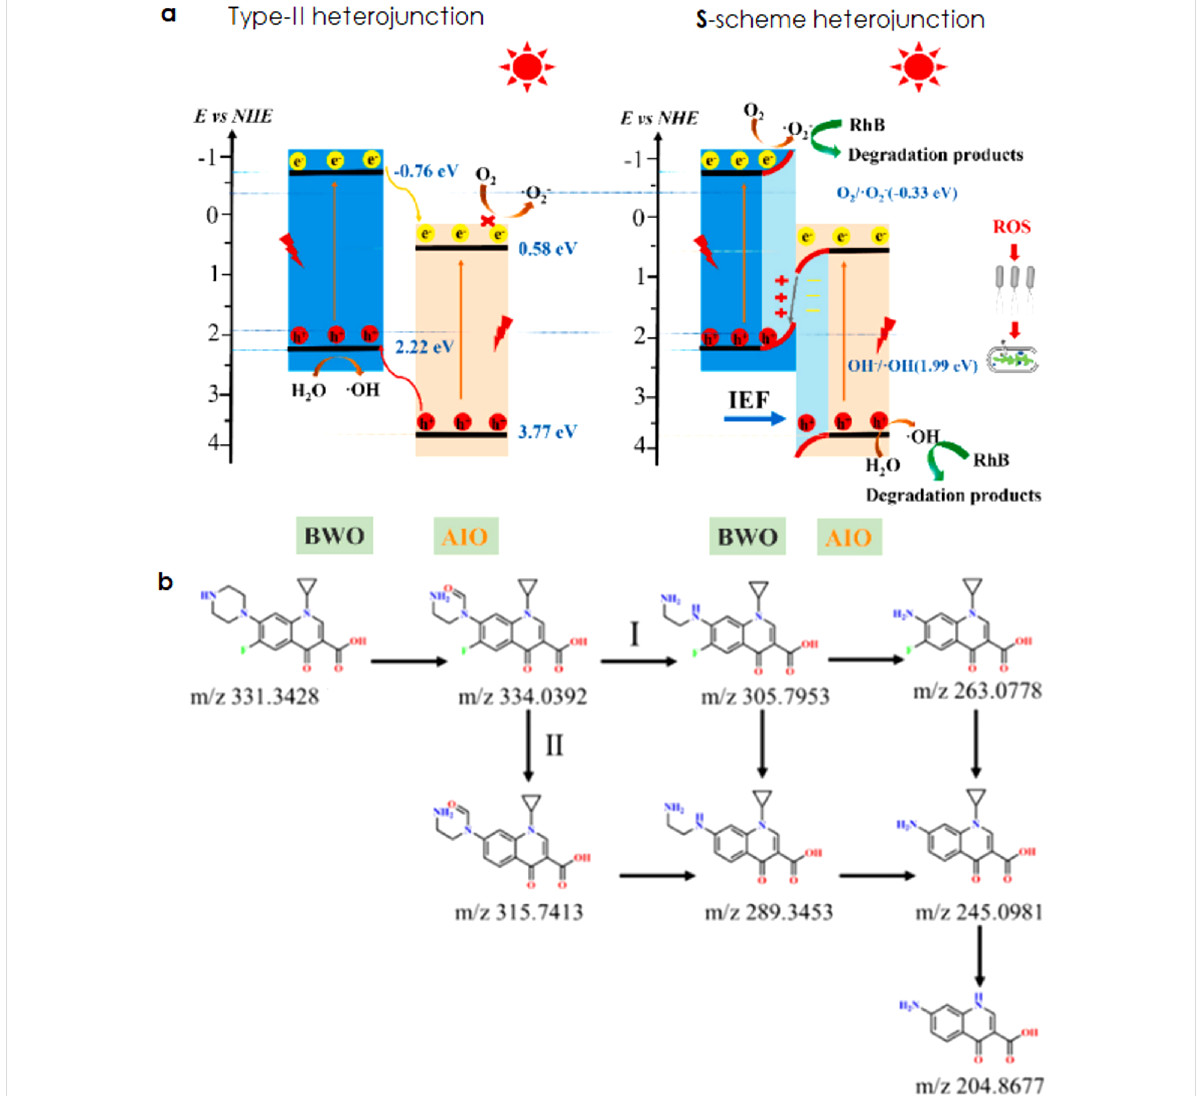
Figure 6: (a) Photocatalysis mechanisms of bismuth-based nanosheets via S-scheme heterojunction and type-II heterojunction systems (Figure 6a was adapted from [143], Ceramics International, Vol. 48, Issue 17, by Z. Liu; H. Wang; J. Duan; B. Hou, “An S-scheme heterojunction of Bi 2 WO 6 / AgIO 3 nanocomposites that enhances photocatalytic degradation of Rhodamine B and antifouling properties“, Pages 24777–24787, Copyright (2022), with permission from Elsevier. This content is not subject to CC BY 4.0.). (b) The degradation pathways of ciprofloxacin by Mg-doped Bi 2 WO 6 (Figure 6b was adapted from [110], Chemosphere, Vol. 252, by F. Zhu; Y. Lv; J. Li; J. Ding; X. Xia; L. Wei; J. Jiang; G. Zhang; Q. Zhao, “Enhanced visible light photocatalytic performance with metal-doped Bi 2 WO 6 for typical fluoroquinolones degradation: Efficiencies, pathways and